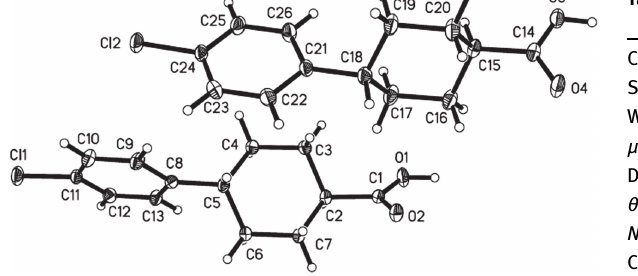
Table 1: Data collection and handling.